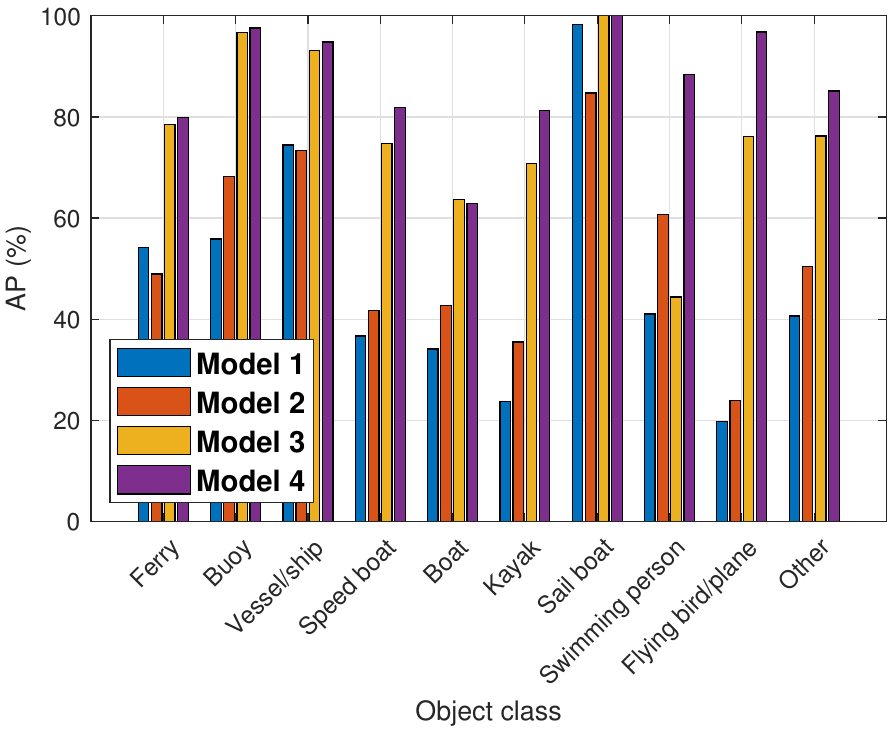
Figure 9. AP of models for each